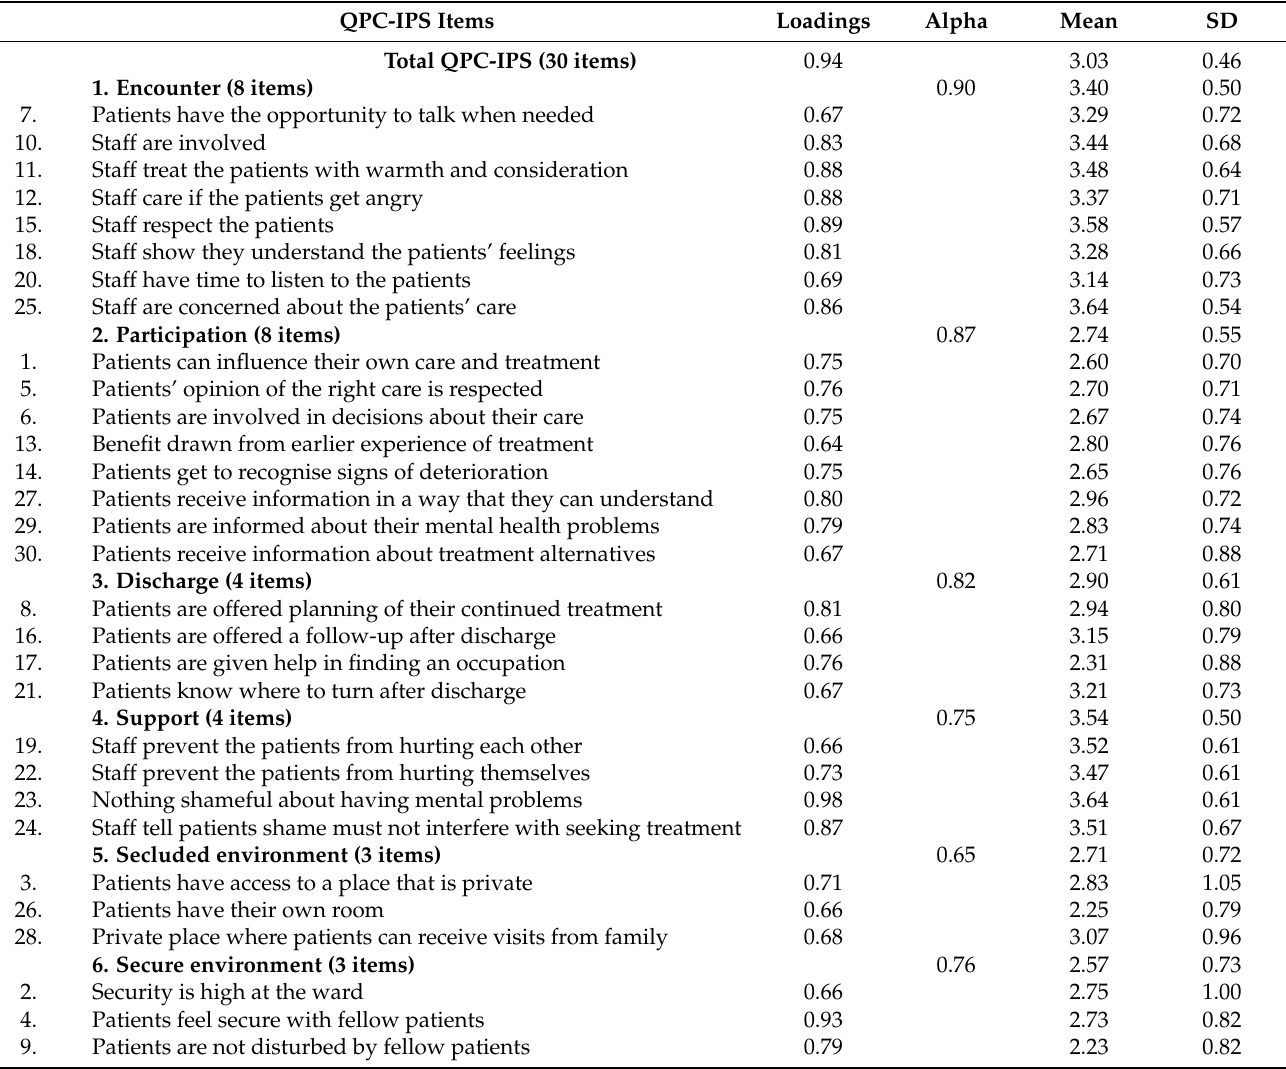
Table 2. Summary statistics for the